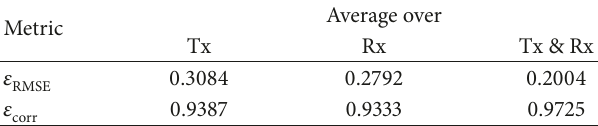
Table 4: Estimation error metrics after